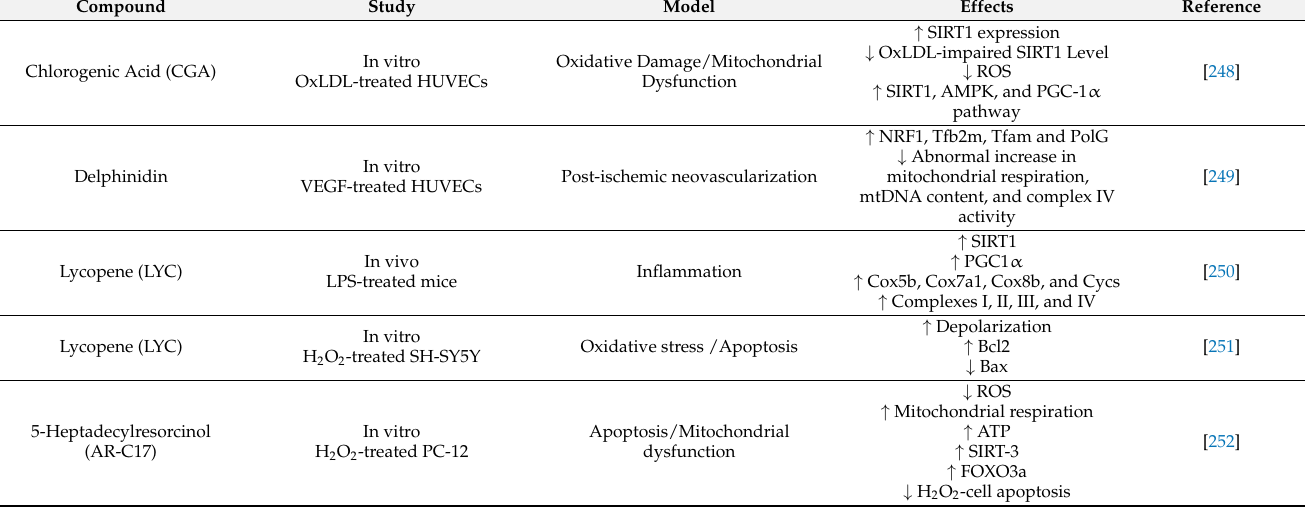
Table 3. Summary of in vitro and in vivo studies about effects of Mediterranean diet on metabolic diseases targeting